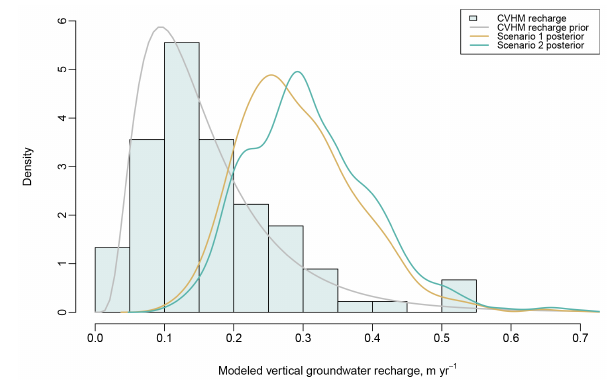
Figure 3. CVHM-estimated annual vertical groundwater recharge (grey bars), log-normal prior probability density for recharge input to model (grey line) and model-estimated posterior probability den- sity for the annual recharge rate for scenario 1 (tan) and 2